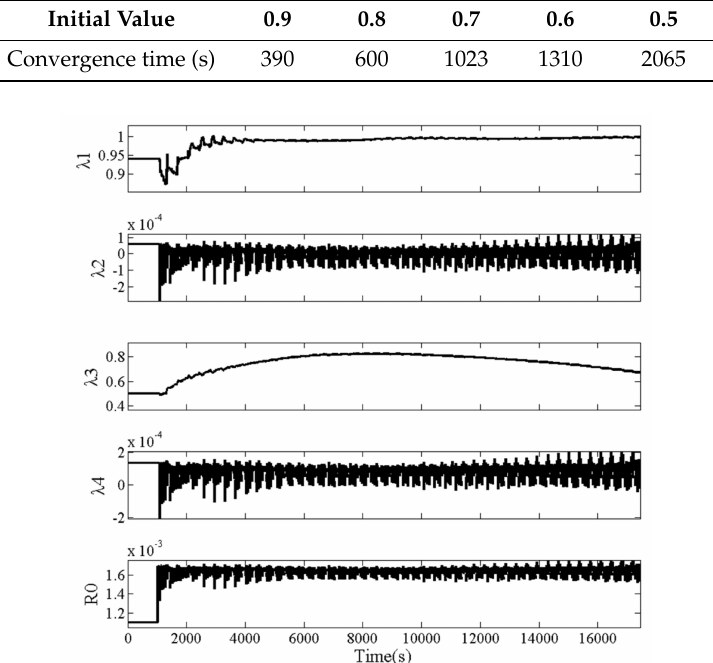
Figure 19. The curves of parameter modification when the initial SoC =